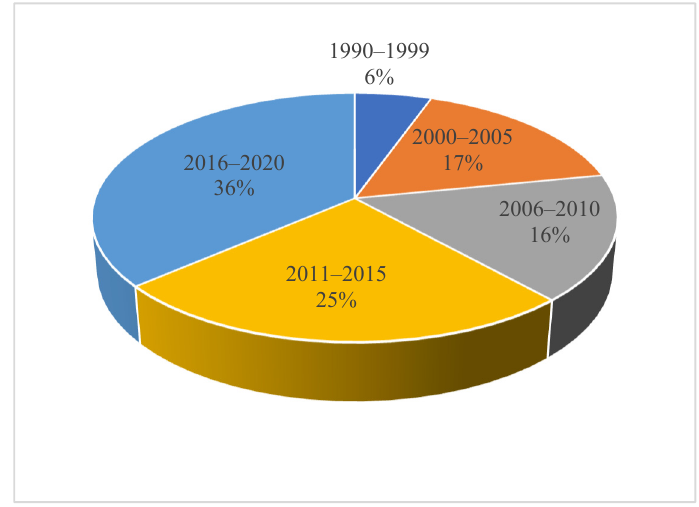
Figure 2. Publication period of the analyzed studies.